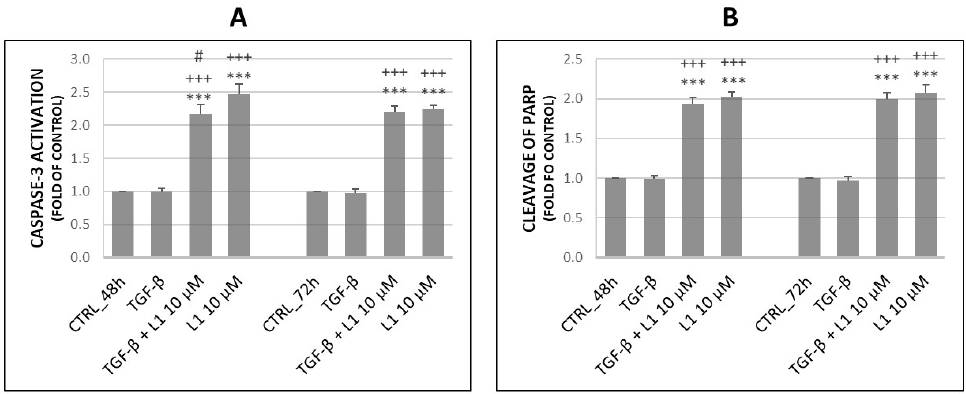
Figure 3. Changes in activation of Caspase-3 ( A ) and cleavage of PARP ( B ) obtained by flow cytometry on HeLa cells after 48 h and 72 h of L1 and TGF- β treatment. Representative data of three independent experiments are presented. Significantly different *** p < 0.001 vs. untreated cells (control); +++ p < 0.001 vs. TGF- β ; # p < 0.001 vs. L1. Table 2. Flow Cytometric Analysis of Annexin V/PI Staining Performed on HeLa Cells after 24, 48 and 72 h of L1 and TGF- β Treatment.